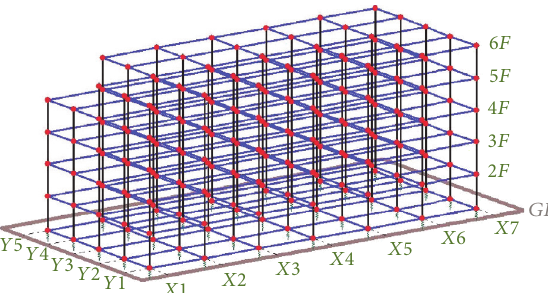
Figure 3: Side elevation of the reinforced concrete